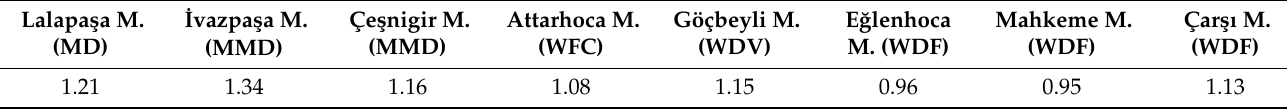
Table 11. The bass ratio values measured in the eight mosques.